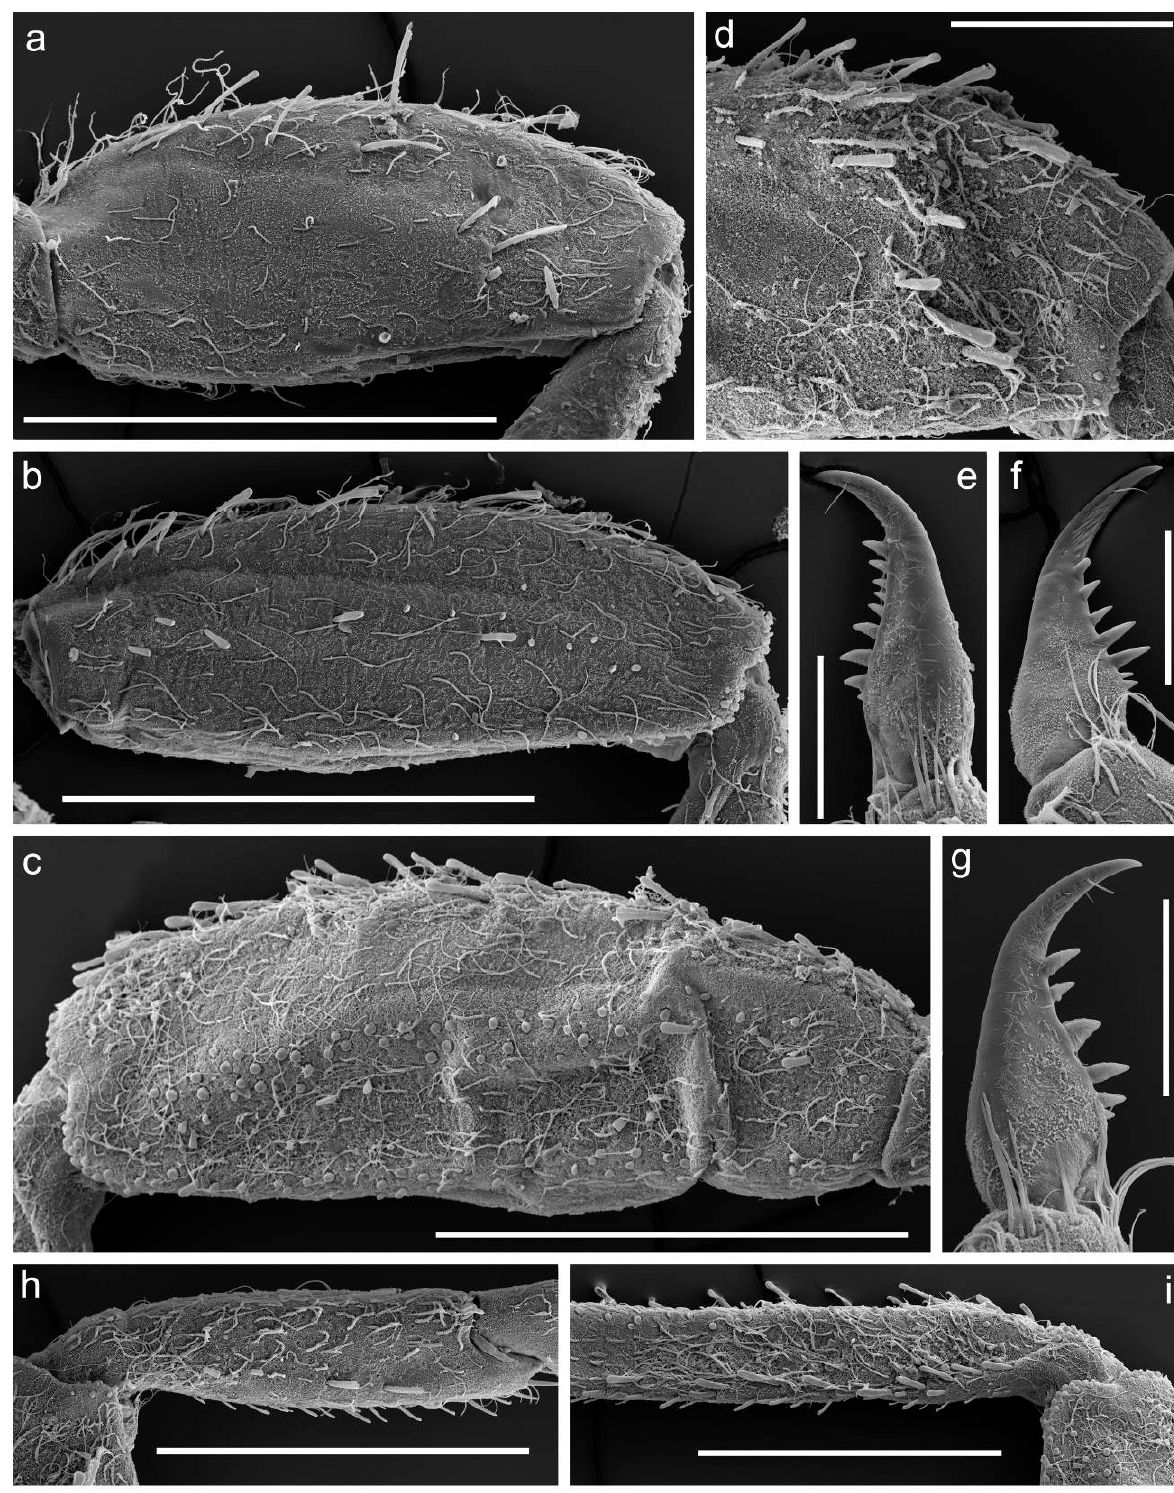
Figure 4. Larva of Serratella leonidi Martynov & Palatov, sp. nov. , paratypes. ( a ) Forefemur, ( b ) middle femur, ( c ) hind femur, ( d ) transverse row of stout setae on fore femur, ( e – g ) tarsal claws, ( h ) fore tibia, ( i ) middle tibia. Scale bars: ( a – c , h , i )—0.5 mm, ( d )—0.2 mm, ( e – g )—0.1 mm.